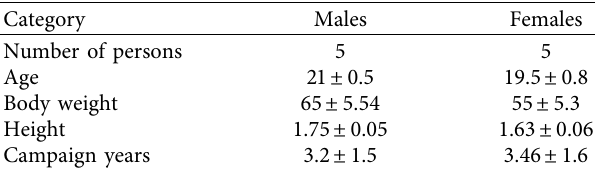
Table 3: Basic information on experimental